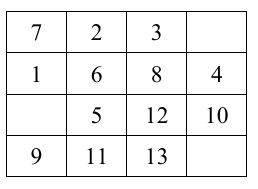
Fig. 2. An example of multi-line facility layout problem